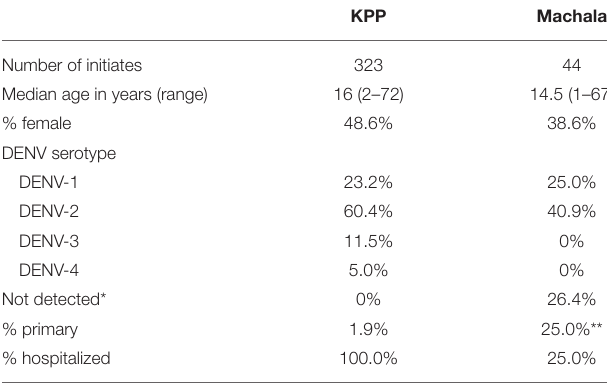
TABLE 3 | Features of Initiates in Thailand and Ecuador.